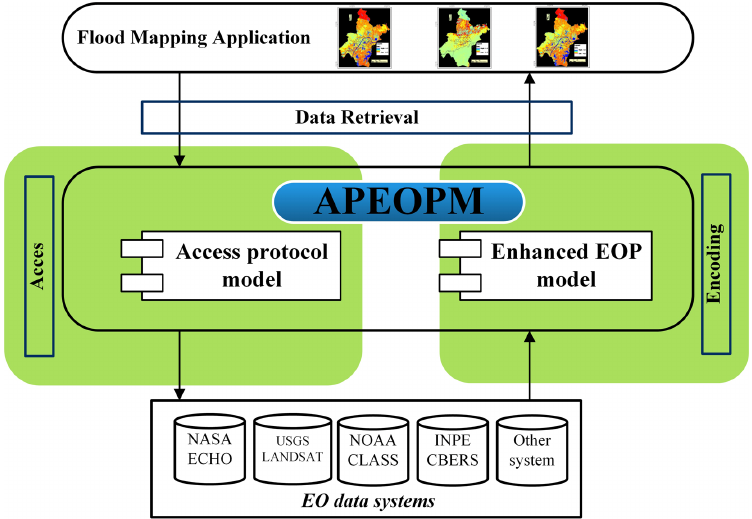
Figure 1. Architecture of the proposed access protocol and enhanced EO metadata profile model (APEOPM). In the whole figure, the green boxes stand for the individual parts of the model: the left green box is the access protocol model as shown in Section 2.1; the right green box stands for the enhanced EOP model, as shown in Section